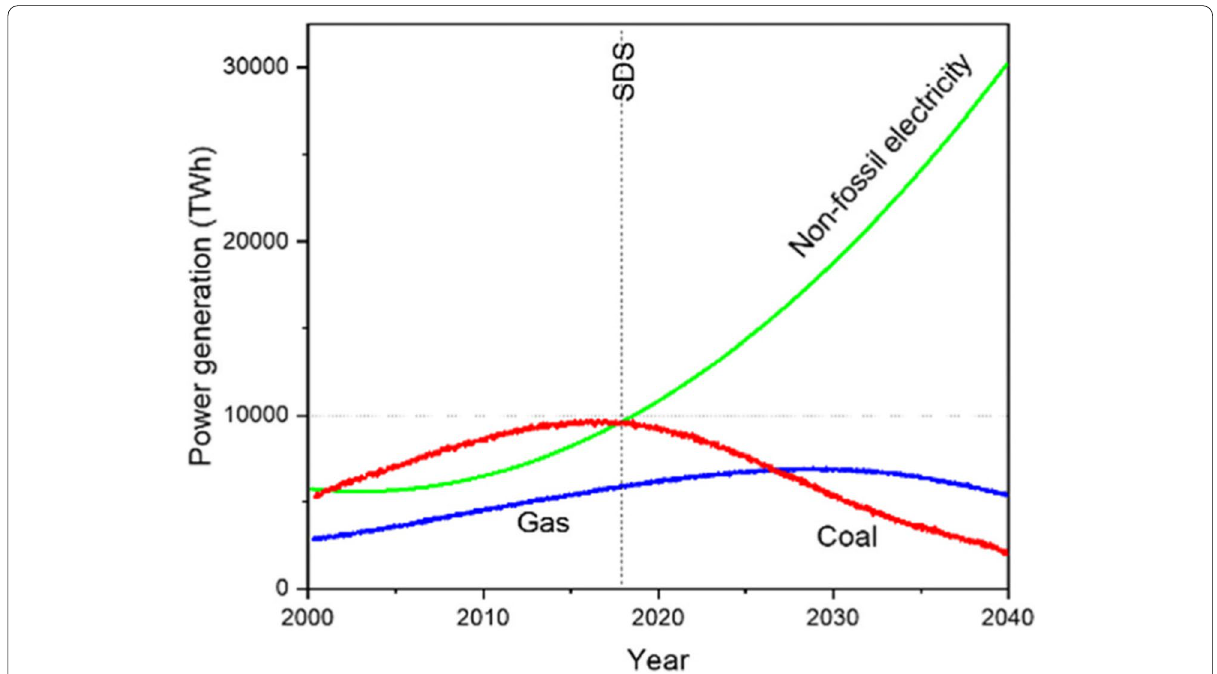
Fig. 1 Power generation in the Sustainable Development Scenario, 2000–2040 [3]